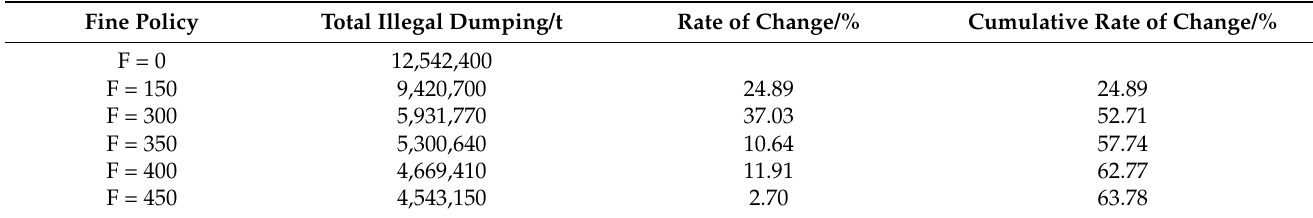
Table 2. Changes in the total amount of illegal dumping corresponding to different fines.